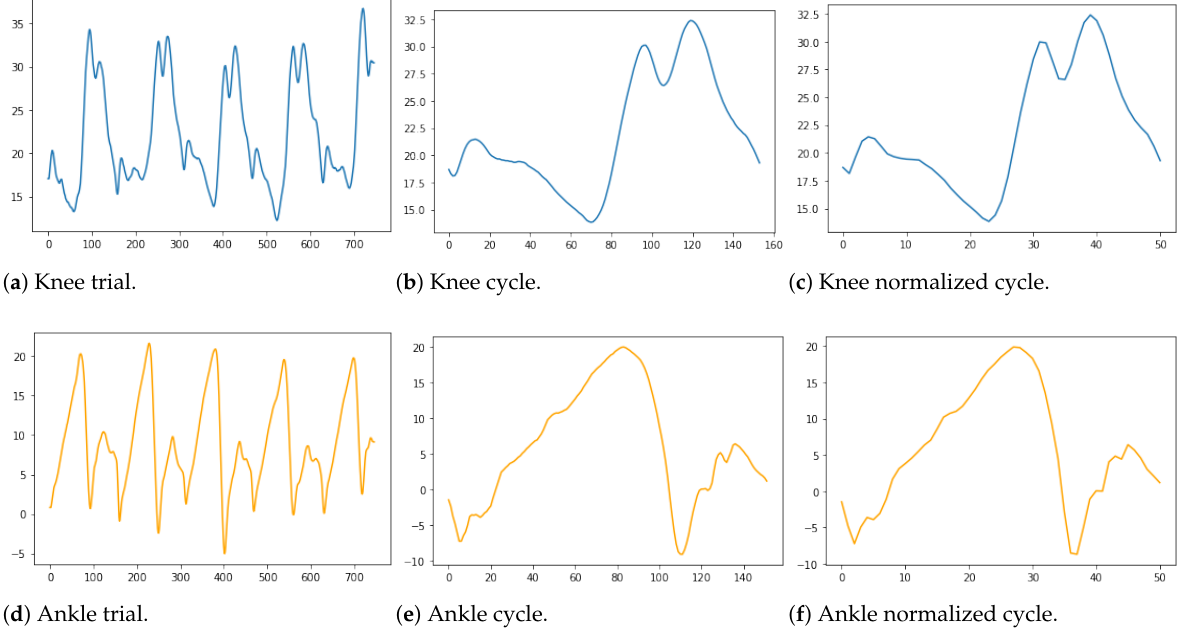
Figure 3. Process of converting one trial to one normalized